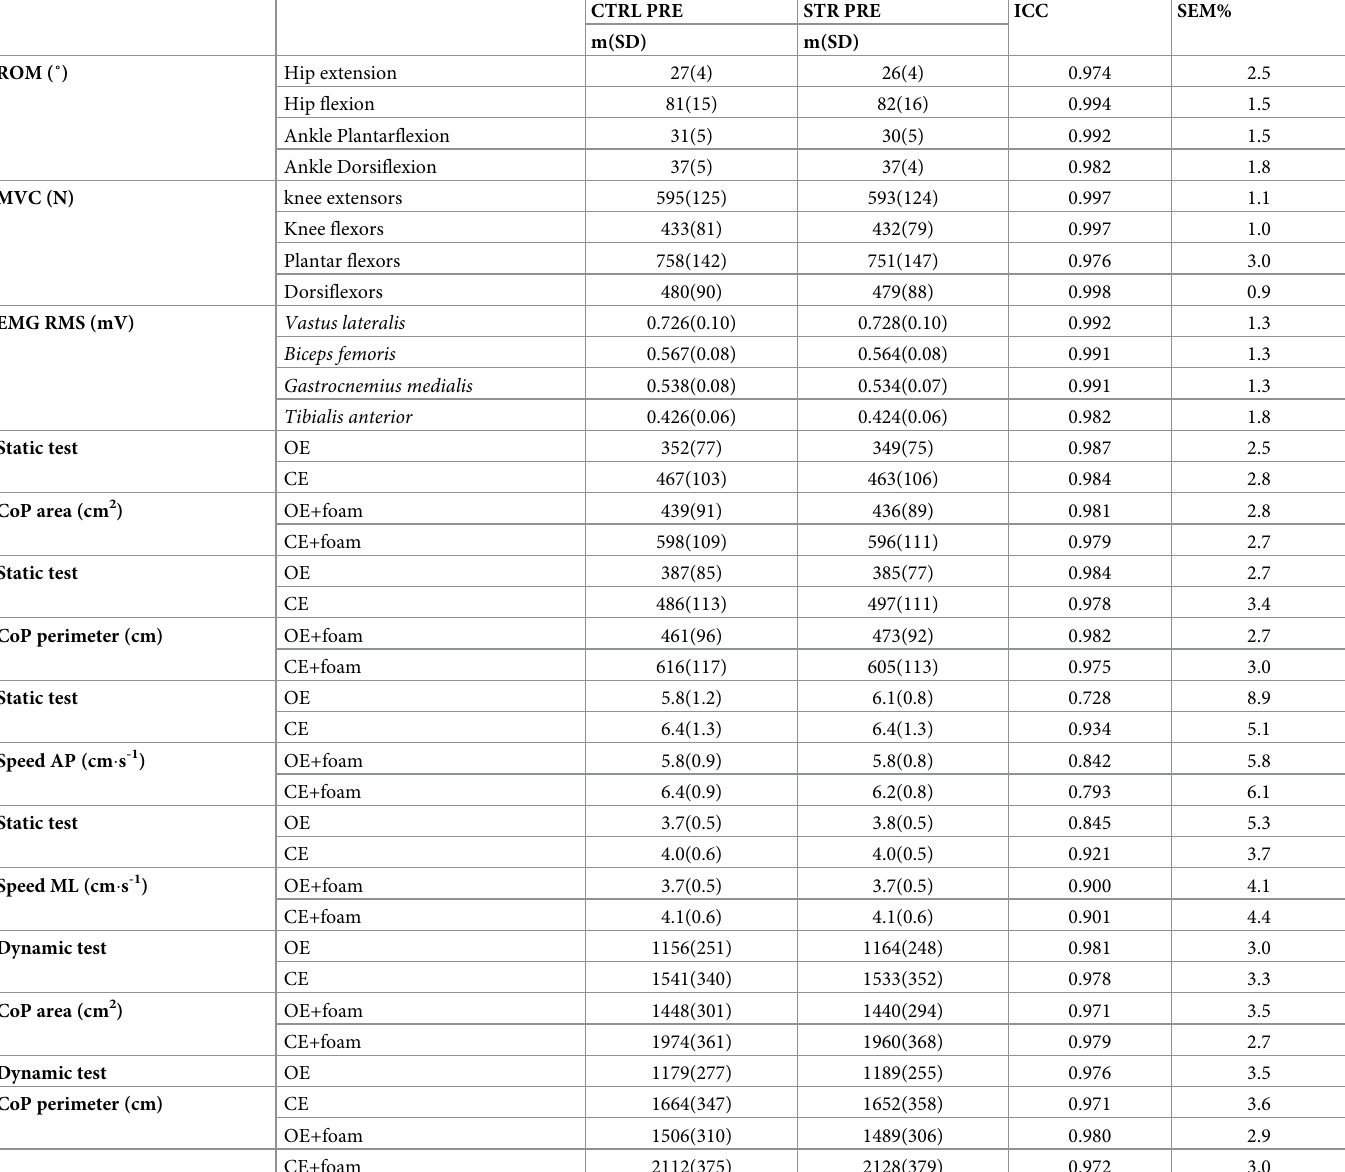
Table 1. Intersession repeatability of range of motion measurements (ROM), maximum voluntary contraction (MVC), root mean square of the surface electromyo- graphic signal (sEMG RMS), area and perimeter of the center of pressure (CoP), velocity in the antero-posterior (AP) and mediolateral (ML)